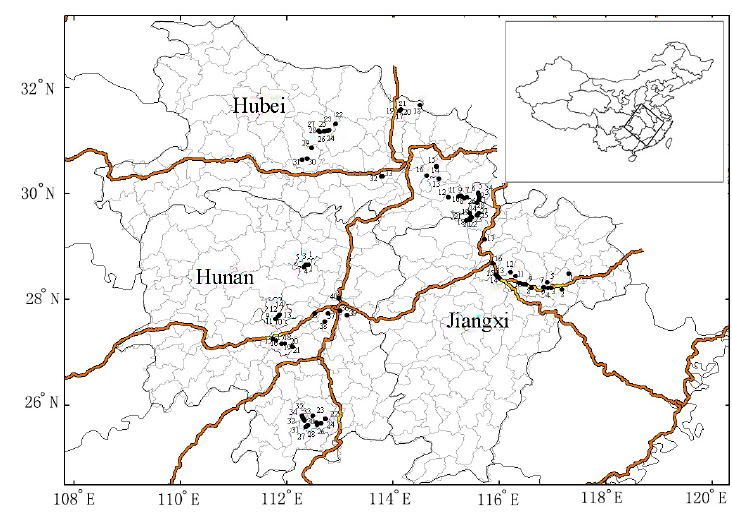
Figure 1. Distribution of sampling sites in the Yangtze River region (Hubei, Hunan and Jiangxi).